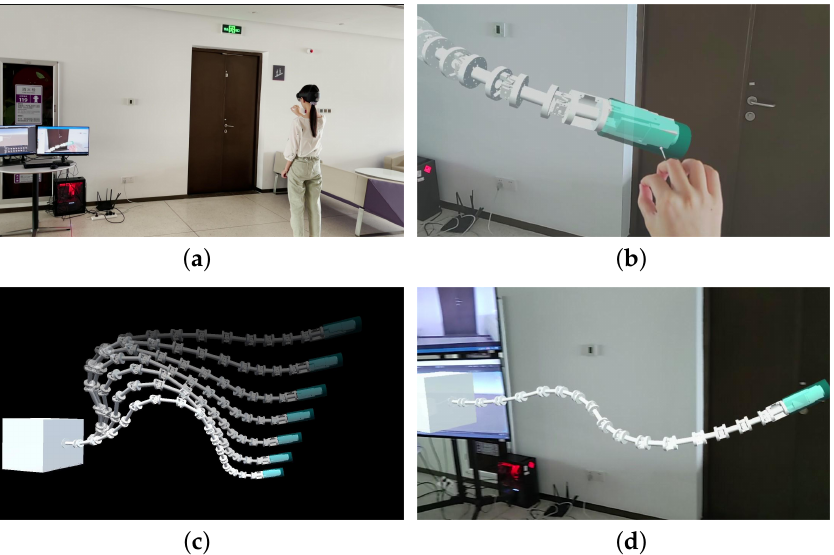
Figure 9. MR-based teleoperation experiment 1. ( a ) Operator in the experimental scene. ( b ) Op- erator’s field of view. ( c ) Simulation of the manipulator’s kinematics. ( d ) Virtual model observed in HoloLens.